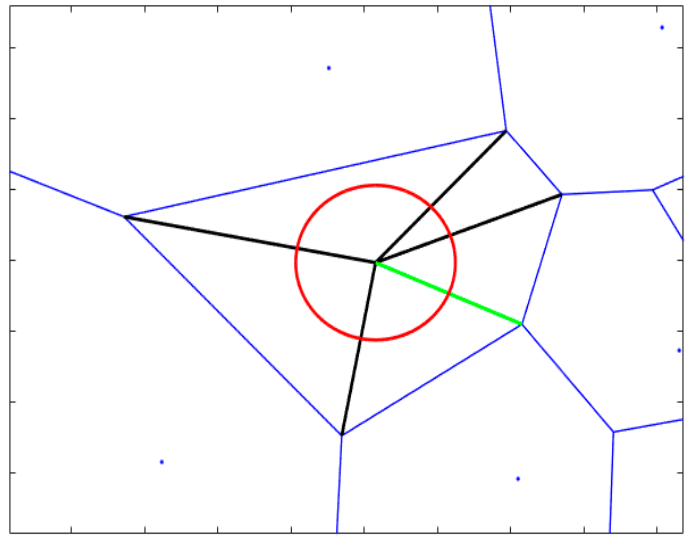
Figure 7. Circular shape center zone of the small cells. Algorithm 2 : Proposed Circular and Irregular Center Zone Determination